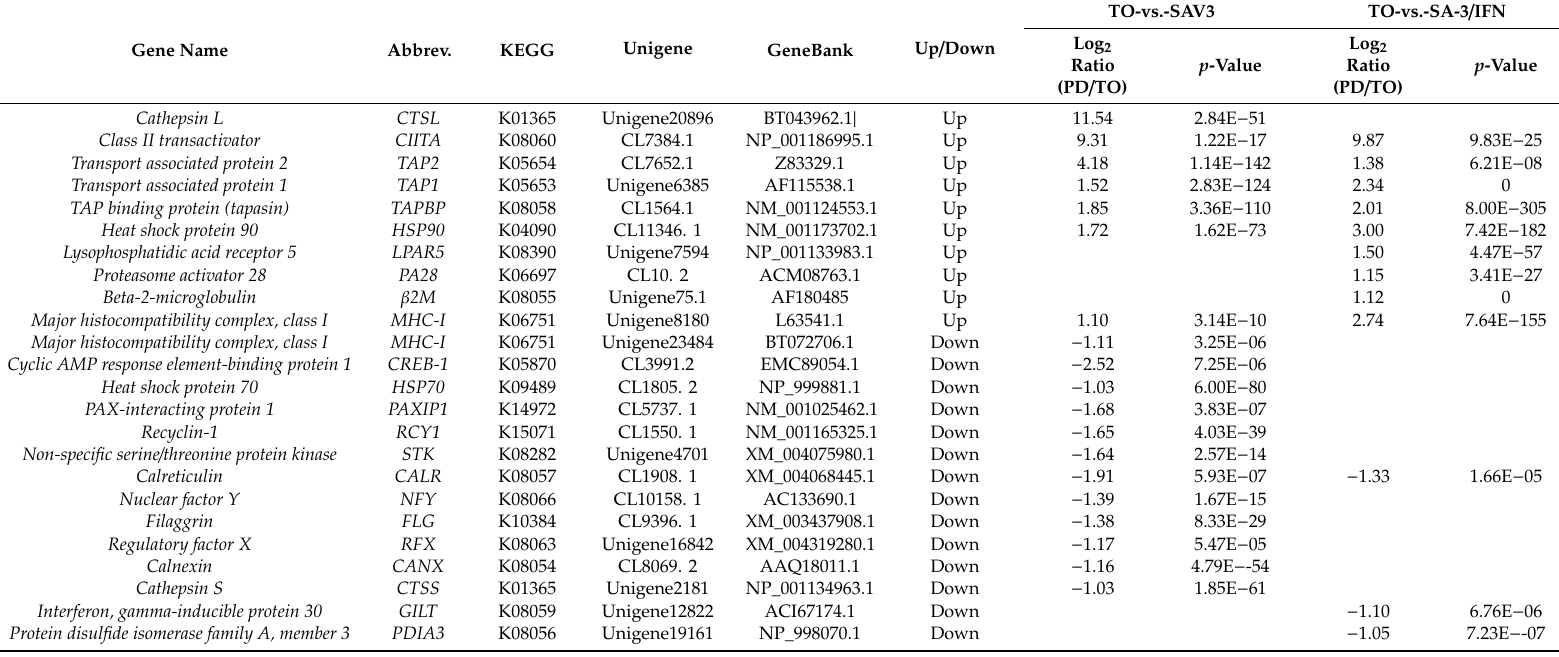
Table 4. Comparison of fold increase in expression level of antigen processing and presentation genes expressed in the TO-vs.-SAV3 / IFN and